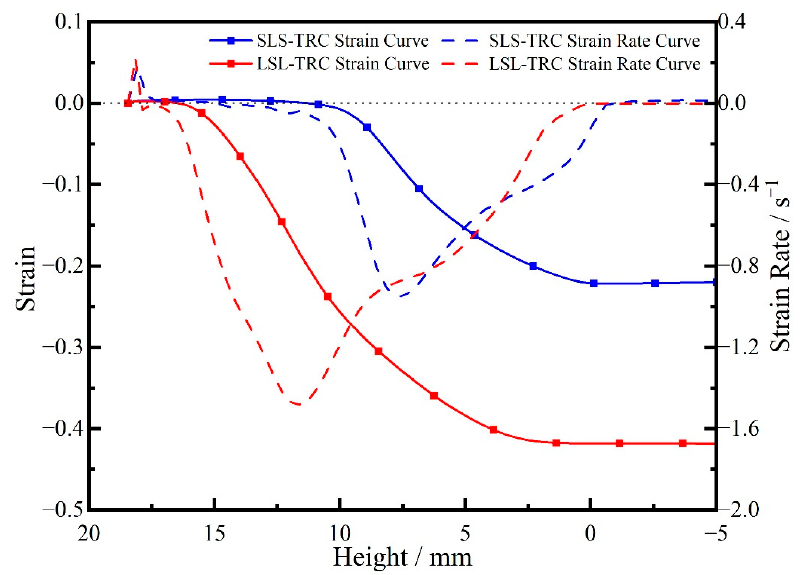
Figure 17. The strain curves and strain rate curves of the solid component in the two processes.